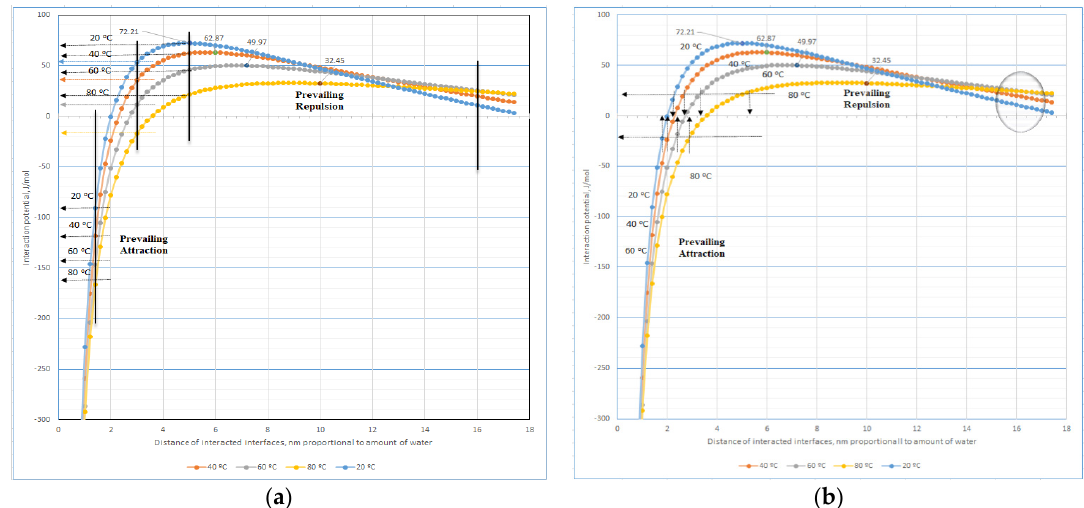
Figure 8. The temperature influence upon both the interaction potential and the distance of mutually interacted micro-planes with mosaic organization of hydrated surfaces of hydro-system at both the constant interaction potential of 20 and − 20 J/mol of interacting water molecules and the constant distance of 1.6; 3; 5 and 9 nm, respectively. ( a ) Constant distance between micro-planes; ( b ) Constant interaction potential.